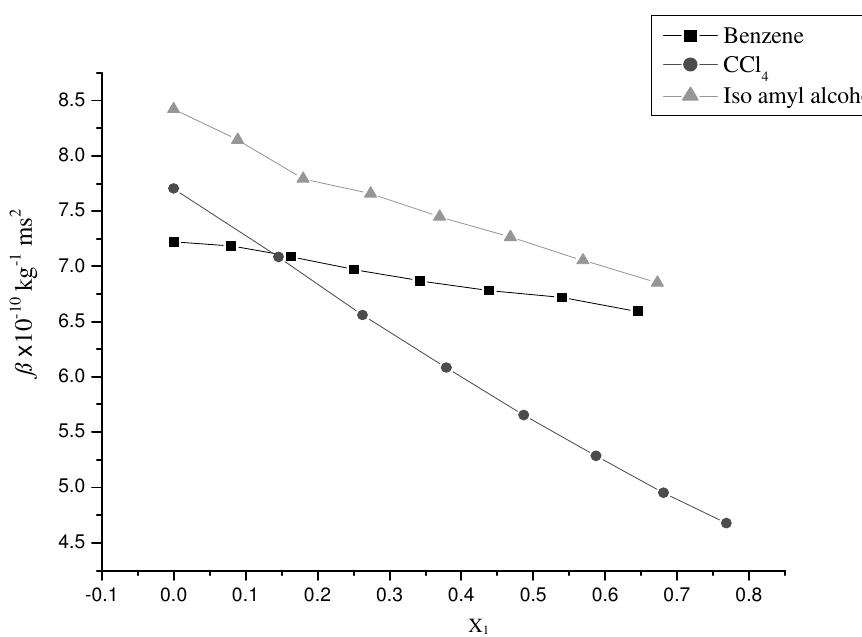
Figure 3. Variation of adiabatic compressibility ( β ), with mole fraction for all the systems